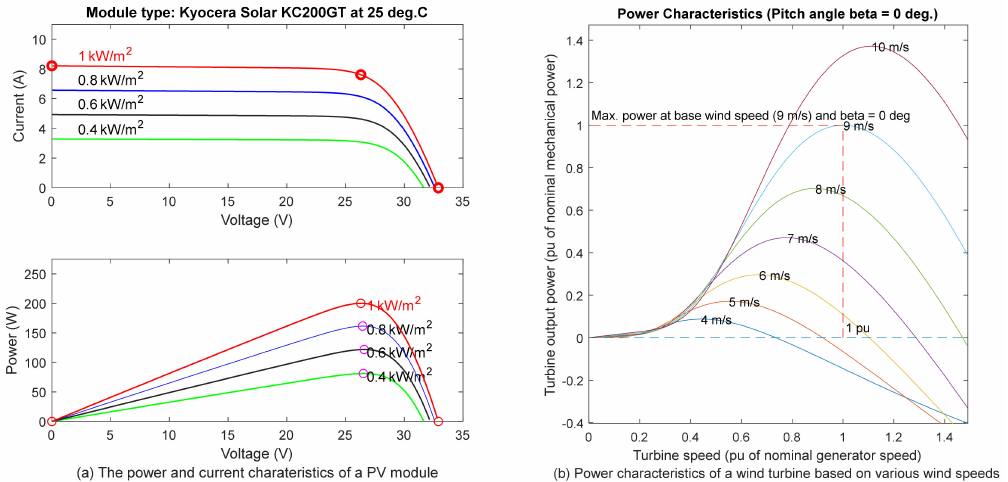
Figure 12. The output power of the solar panel at 25 ◦ C with di ff erent solar radiation and the output power of the wind turbine (WT) with various wind